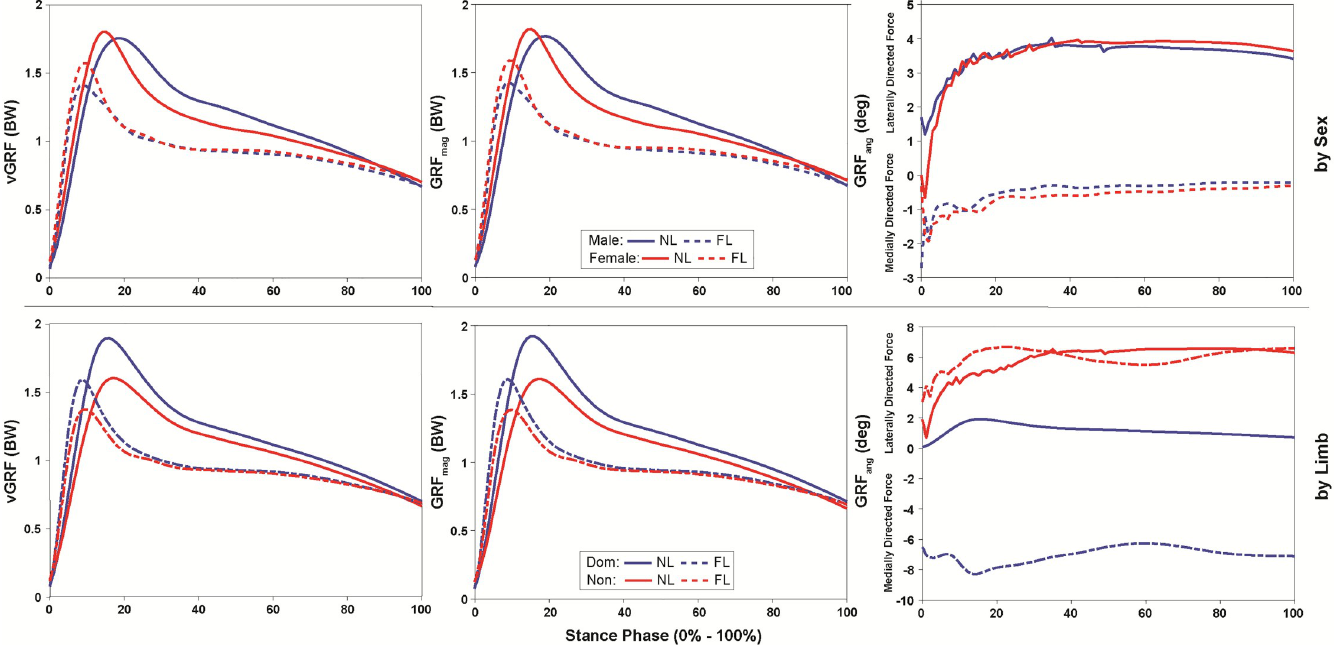
Fig 3. Landing phase (0–100%) vertical ground reaction force (vGRF) and frontal plane loading exhibited by males (blue) and females (red), and the dominant (blue) and non-dominant limb (red) during normal (NL, solid line) and flexed (FL, dashed line) landing.